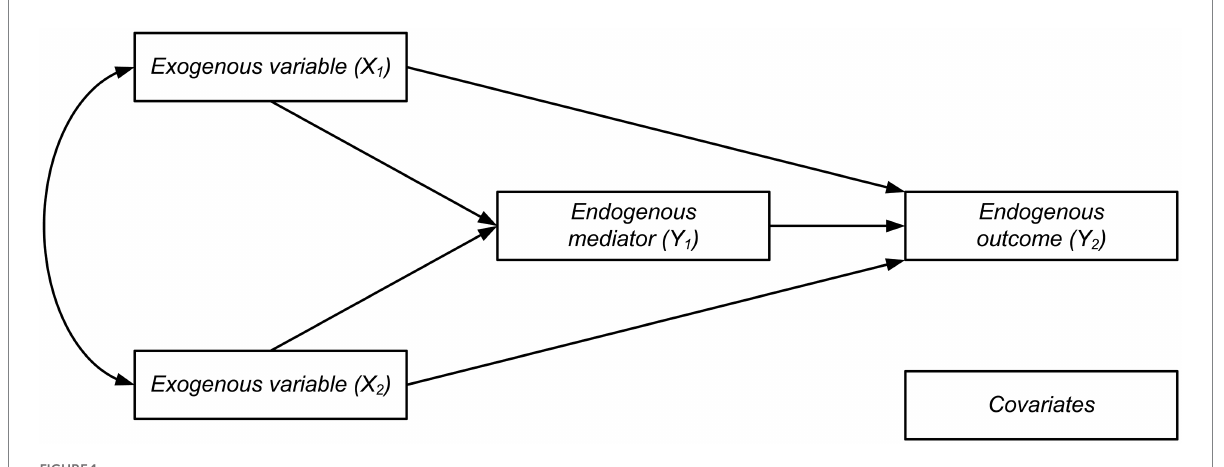
FIGURE 1 The conceptual diagram of the mediation